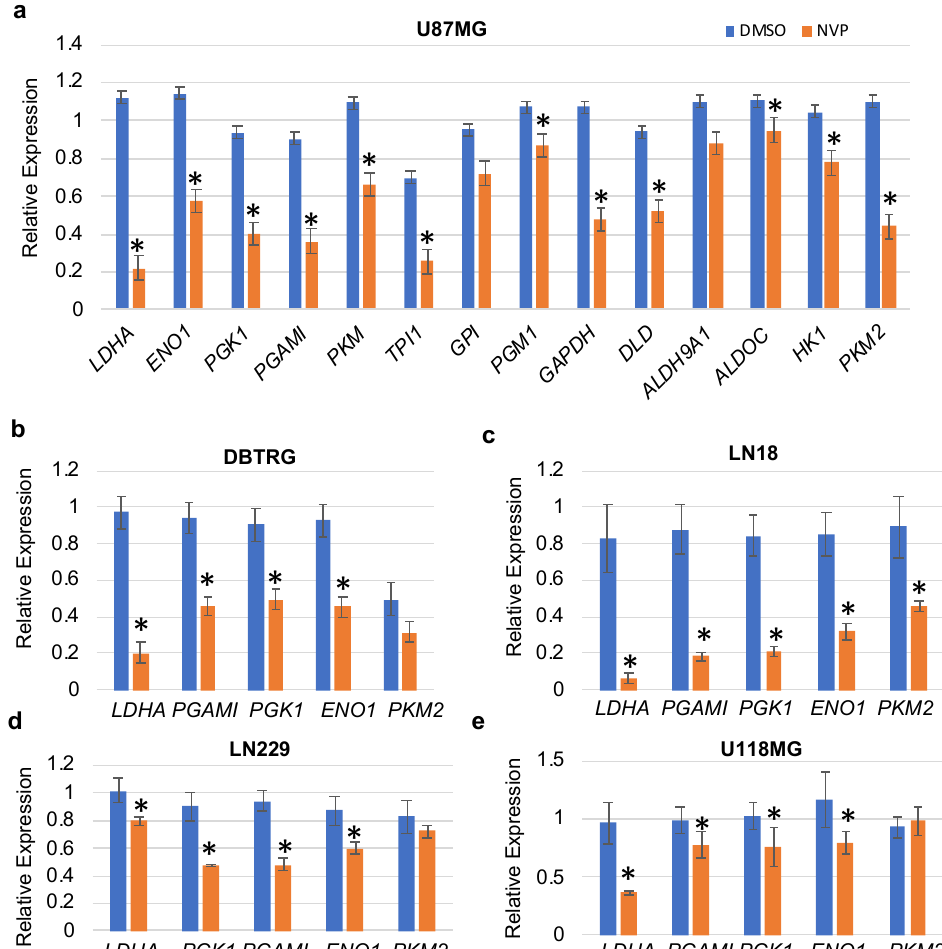
Figure 3. qRT-PCR validation of the glycolytic genes in various cell lines. ( a ) U87MG, ( b ) DBTRG, ( c ) LN18, ( d ) LN229, and ( e ) U118MG. The relative expression of the genes (compared to ACTB , encoding actin) was analyzed in control and NVP-BEZ235 (NVP) samples (1 µ M treatment for 5 days). The error bars represent the standard deviation of the genes (n = 4). Asterisks (*) represent the significantly expressed genes ( p < 0.05) as compared to control (DMSO). Significance was determined by Student’s t-test.